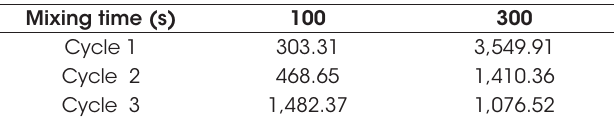
Hysteresis area of mixing samples of 100